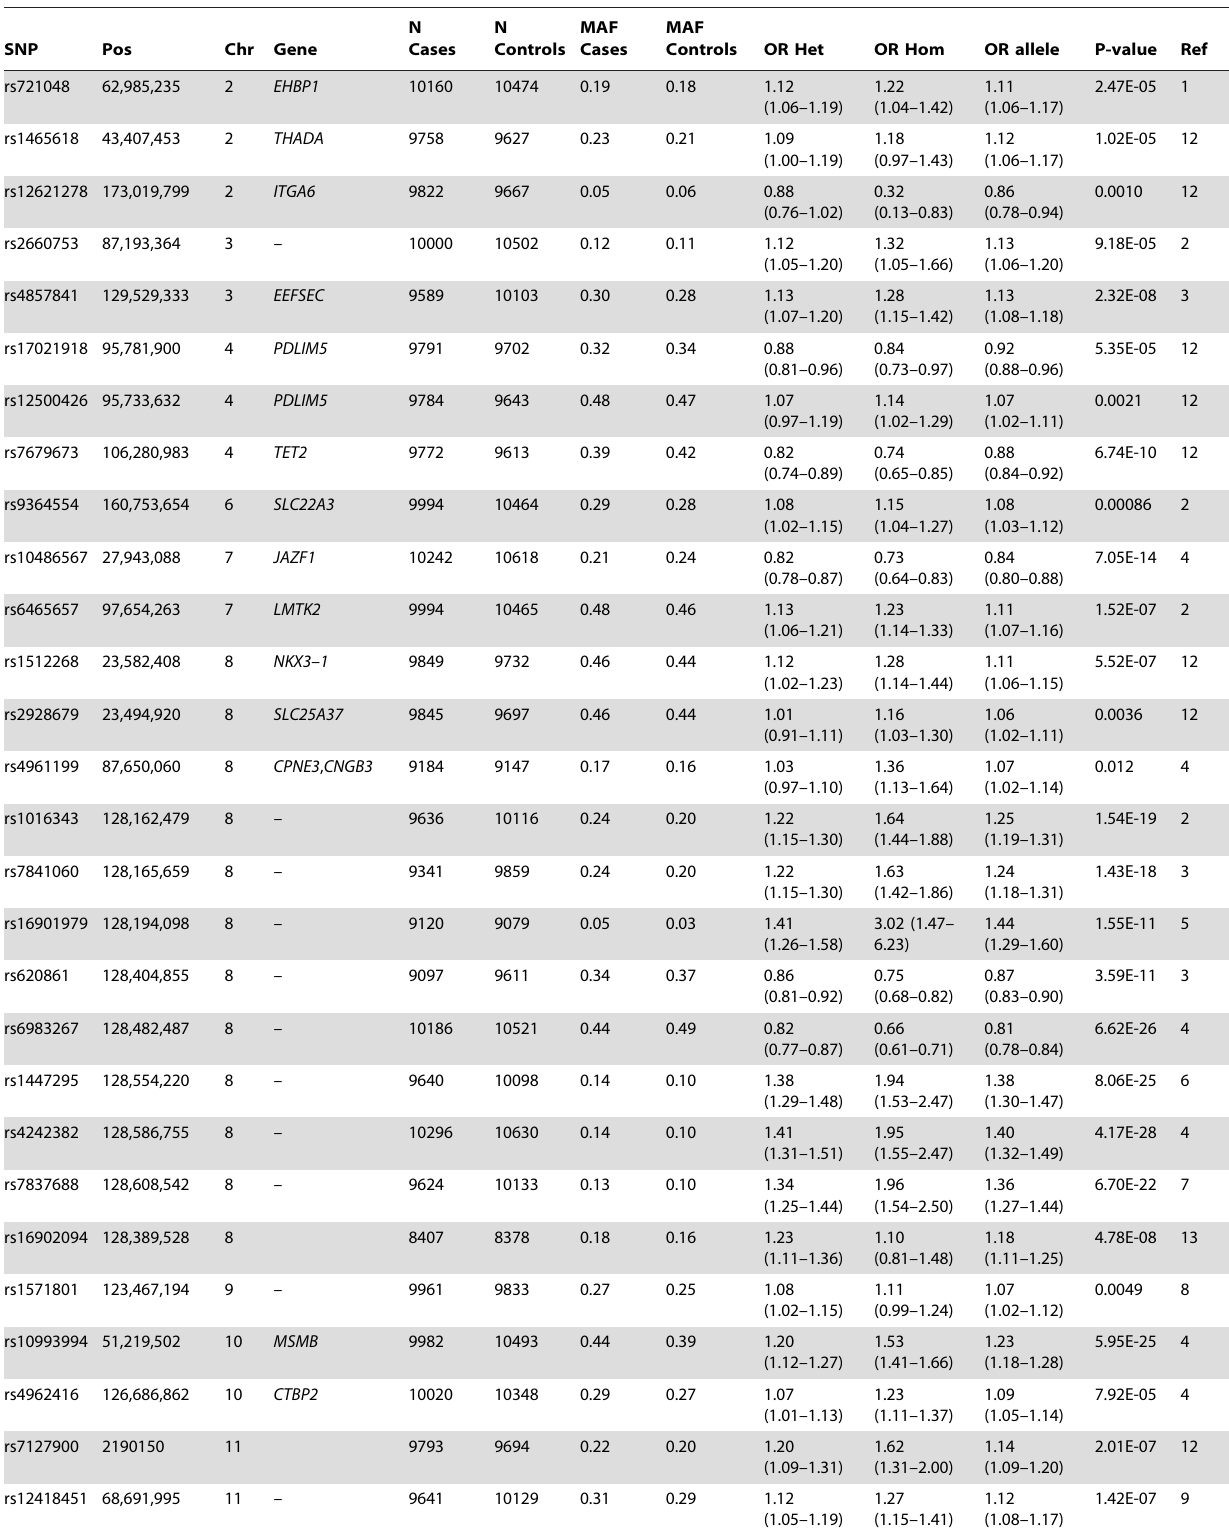
Table 2. Associations between selected SNPs and prostate cancer